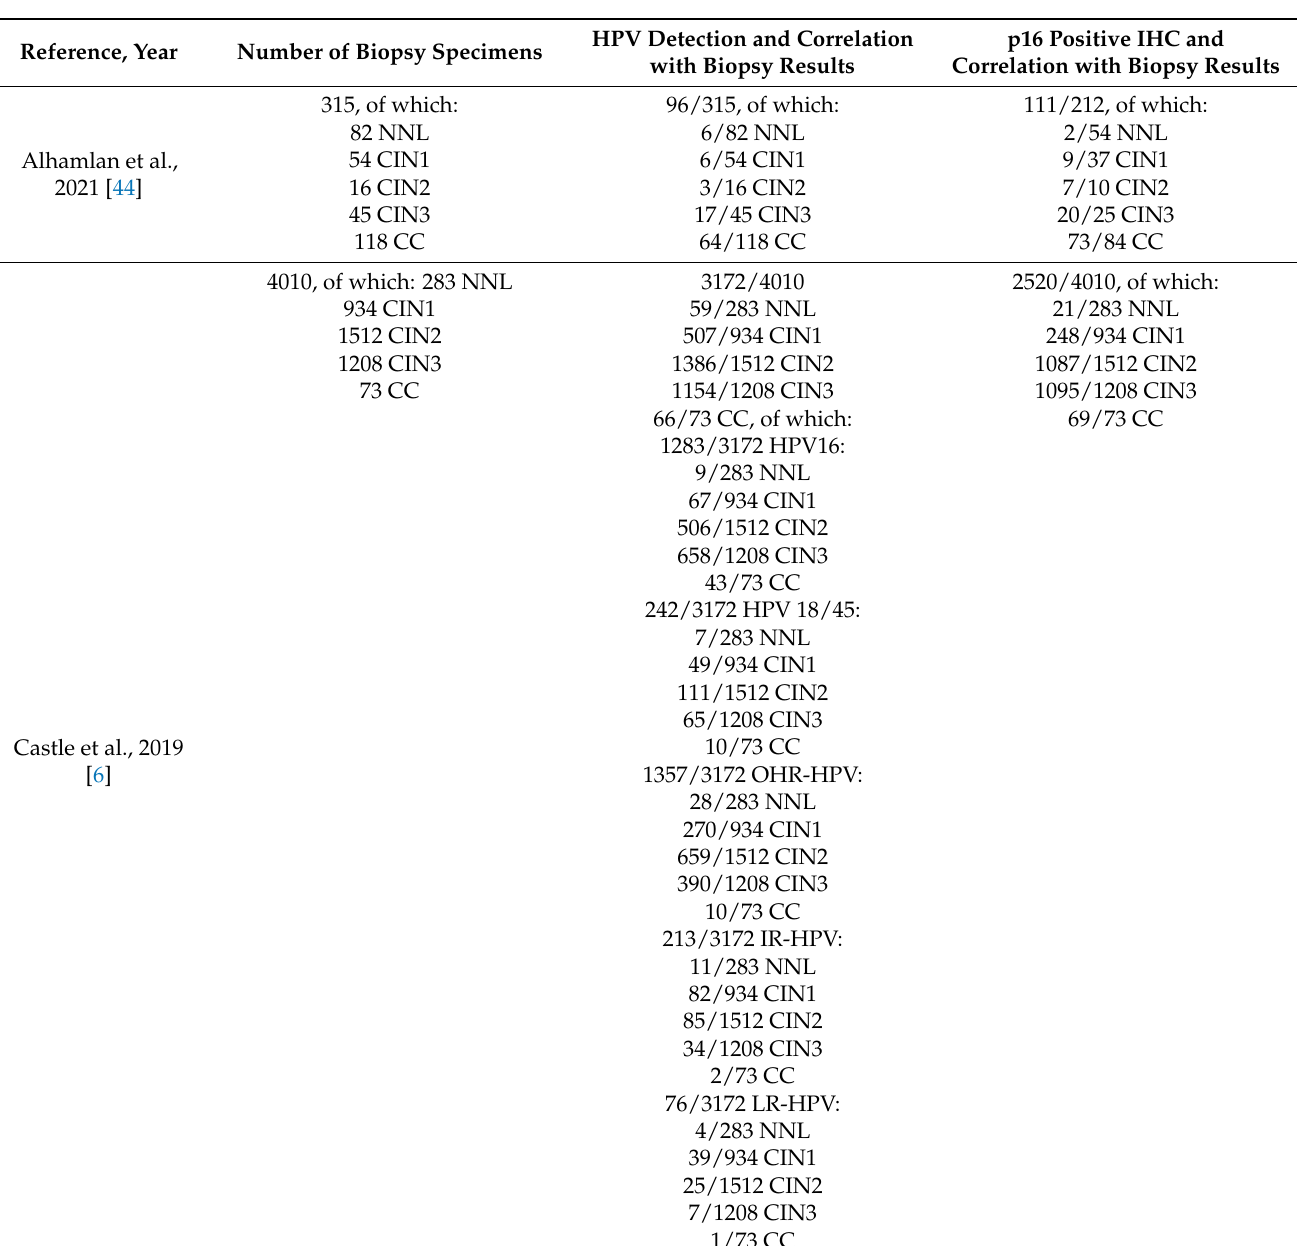
Table 1. p16 IHC in cervical tissue biopsy